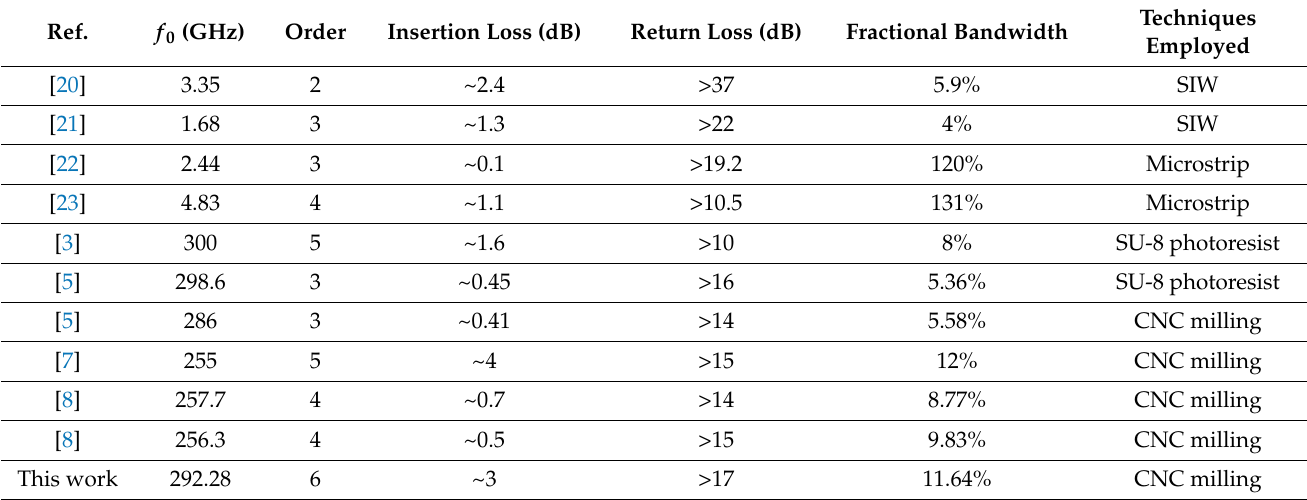
Figure 7. ( a ) Machining half blocks of the proposed THz 6-pole H-plane waveguide filter; ( b ) Geometric configuration. The inset shows the radius due to the CNC milling process; ( c , d ) The photos of the measurement setup. Table 3. Comparison of the state-of-the-art bandpass filters. Ref.